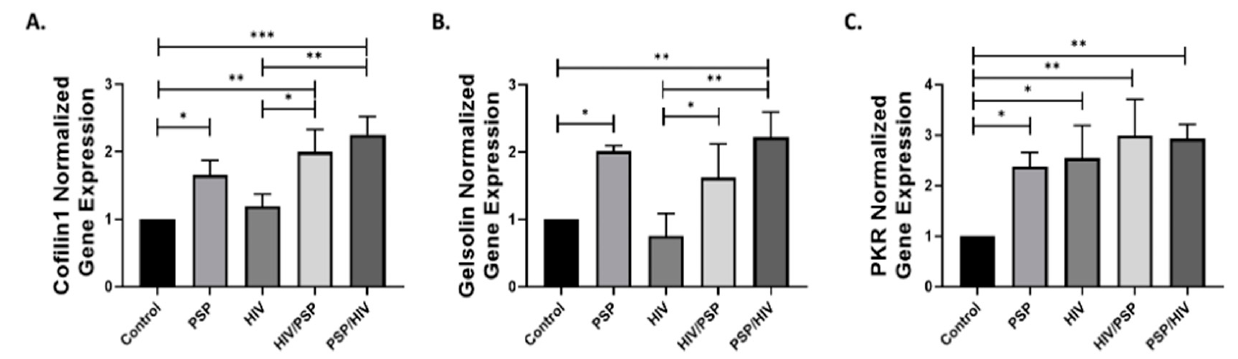
Figure 7. Validation of western blot results using RT-qPCR analysis for cytoskeletal and IFN-IP markers. Relative gene expression analyzed through RT-qPCR approach. The mRNA expression levels for the ADF: ( A ) Cofilin-1; ABP: ( B ) Gelsolin; and IFN-IP: ( C ) PKR are shown. All data were normalized using 18S as a housekeeping gene in response to PSP treatment. Mean ± SEM and significant difference (*), p ≤ 0.05, (**), p ≤ 0.01, (***), p ≤ 0.001 are shown and were determined using one-way ANOVA, with Tukey multiple comparisons test, n = 3.